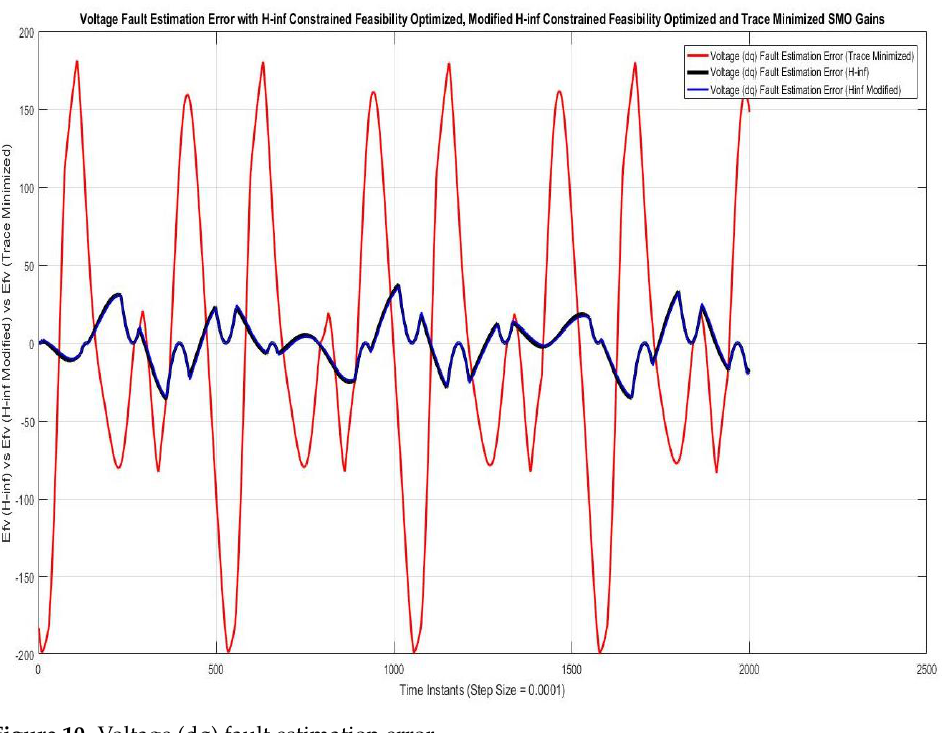
Figure 10. Voltage (dq) fault estimation error.